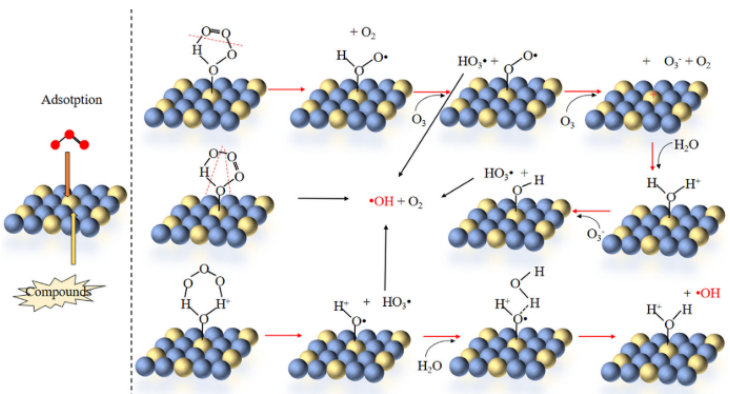
Figure 19. Possible catalytic mechanisms of metal oxides. Reproduced from Ref. [89].